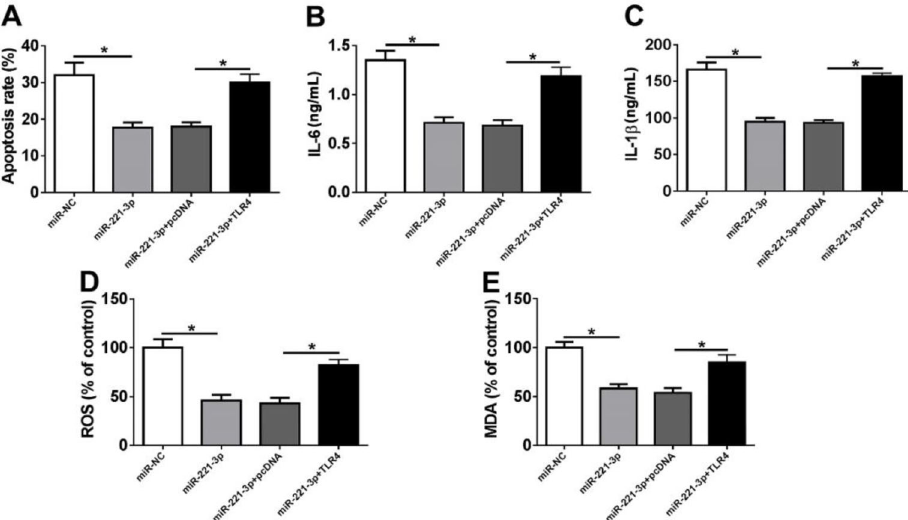
Figure 4. TLR4 overexpression reversed the suppression effects of miR-221-3p on the oxidized low-density lipoprotein (ox-LDL)- induced cellular response in induced human umbilical vein endothelial cells (HUVECs). HUVECs were transfected with miR-221-3p mimic, miR-NC (negative control), miR-221-3p mimic + TLR4, or miR-221-3p mimic + pcDNA, followed by treatment with 50 mg/L ox-LDL. A , The apoptosis rates of HUVECs was examined by fl ow cytometry analysis. B and C , ELISA was used to determine the levels of interleukin (IL)-6 and IL-1 b . D and E , The levels of reactive oxygen species (ROS) and malondialdehyde (MDA) were determined by assay kits. Data are reported as means ± SD from three independent experiments. *P o 0.05 (ANOVA).